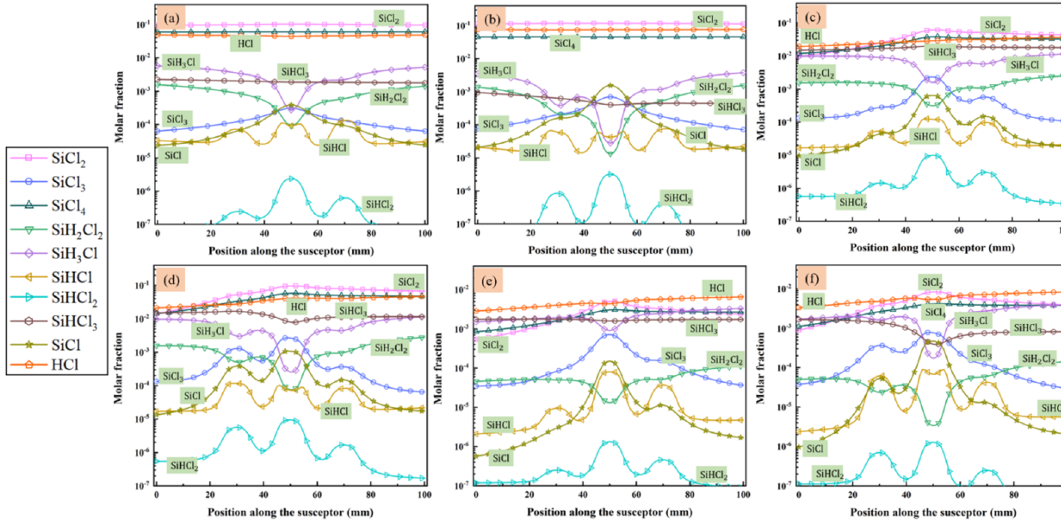
Figure 5. The molar fraction of main species that contained Si/Cl in the gas phase above the susceptor: ( a ) case 1; ( b ) case 2; ( c ) case 3; ( d ) case 4; ( e ) case 5; and ( f ) case